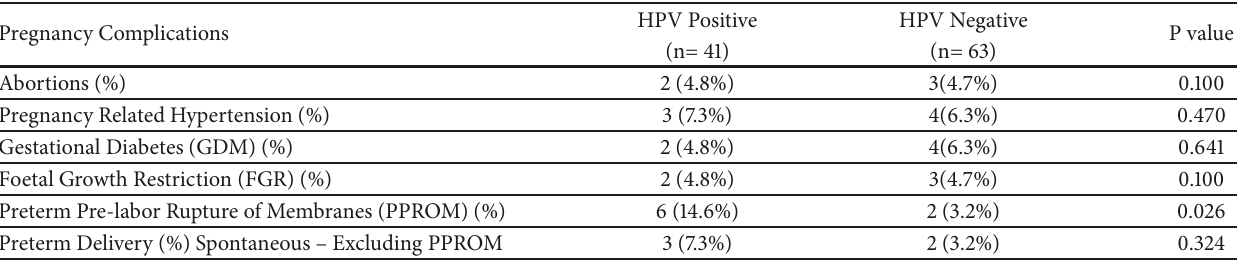
Table 2: Pregnancy complications in HPV positive versus negative